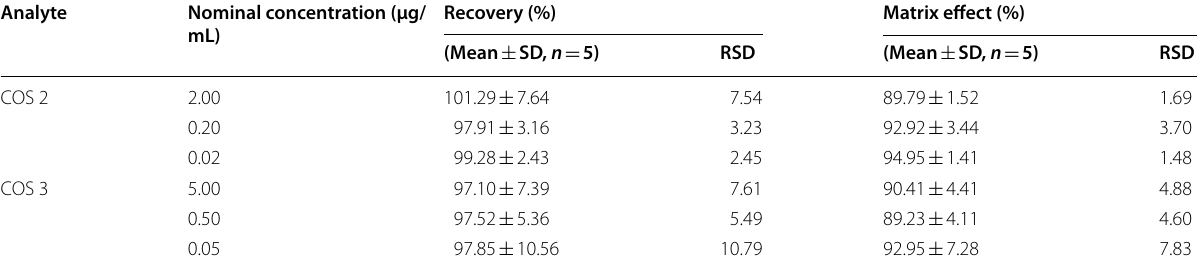
Table 2 Extraction recovery and matrix effect of COS 2 and COS 3 in serum